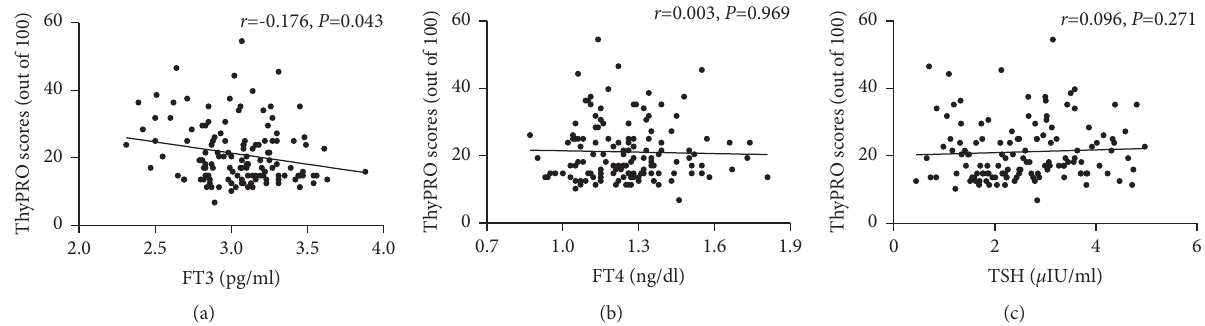
Figure 2: The correlation of FT3 (a), FT4 (b), and TSH (c) levels and ThyPRO composite scores in all patients with HT. Table 3: Logistic regression analysis for the association of FT3, FT4, TSH, and QoL in all patients with HT. Model 1 Model 2 Model 3